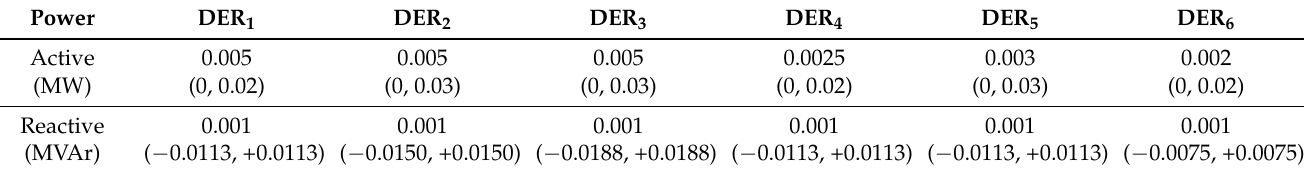
Table 3. Initial values and allowable range of variations for the active and reactive powers injected/absorbed by DERs. Power DER 1 DER 2 DER 3 DER 4 DER 5 DER 6 Active 0.005 0.005 0.005